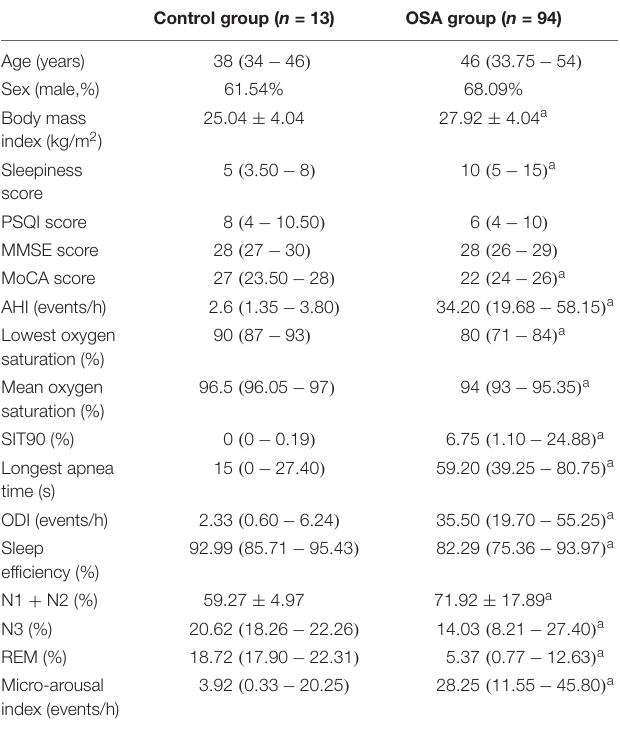
TABLE 1 | Characteristics of enrolled subjects.